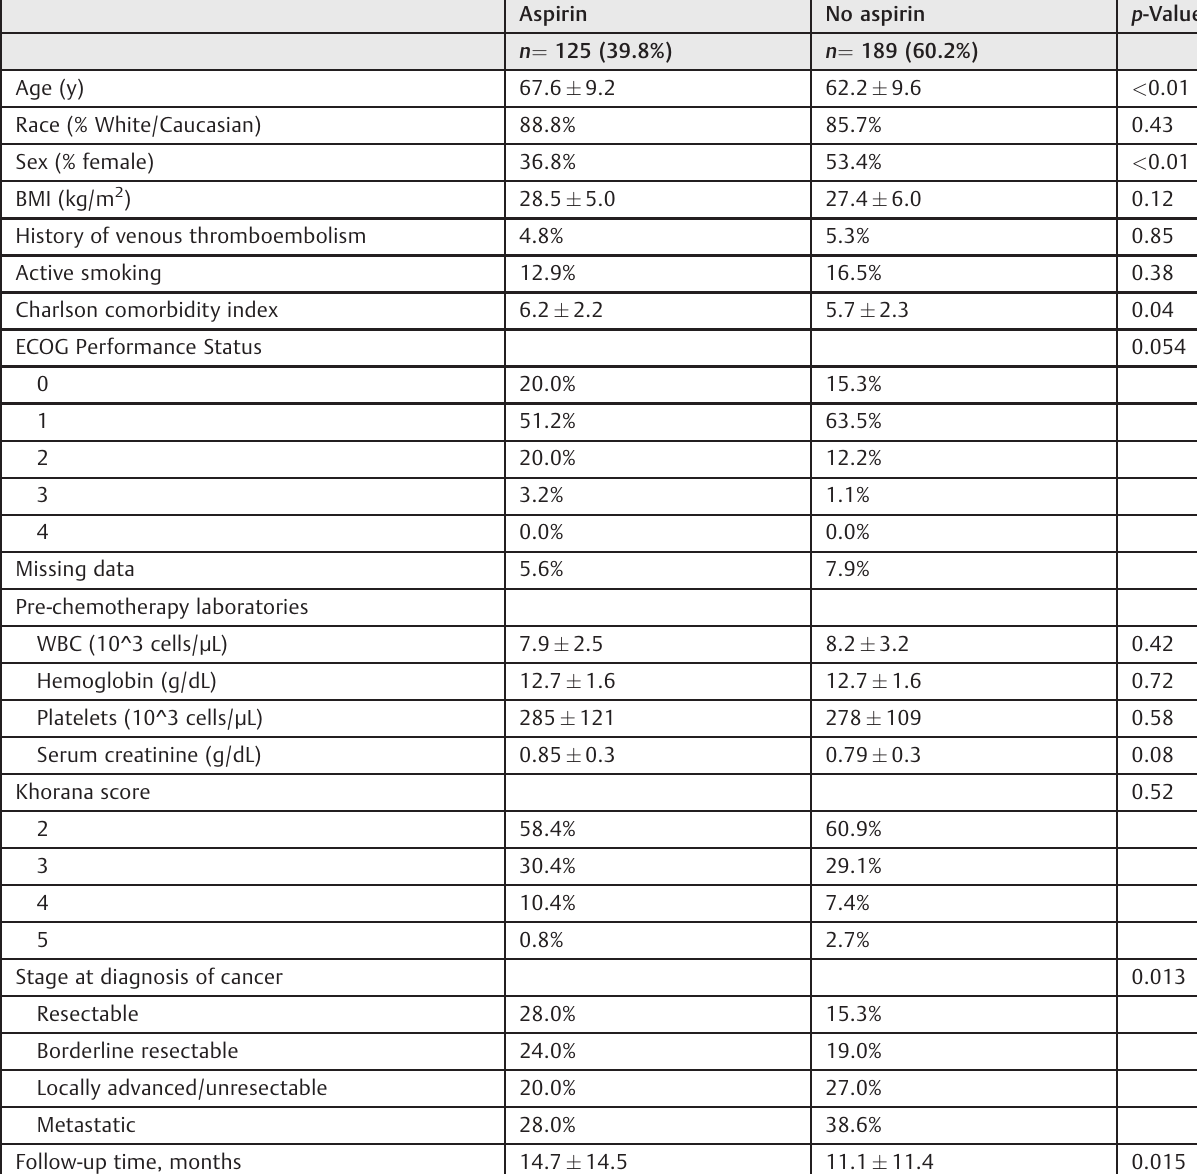
Table 1 Characteristics of patients with pancreatic cancer by aspirin use